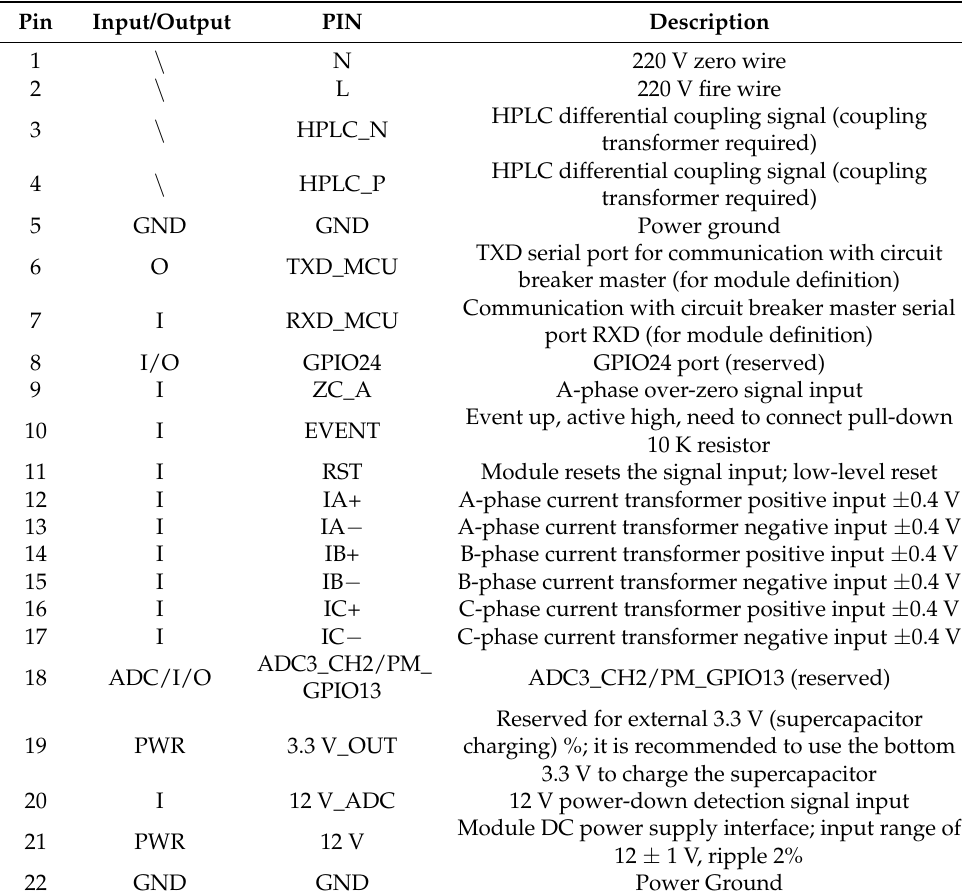
Table 3. Main interface definition and description of HPLC topology module for measurement switch.